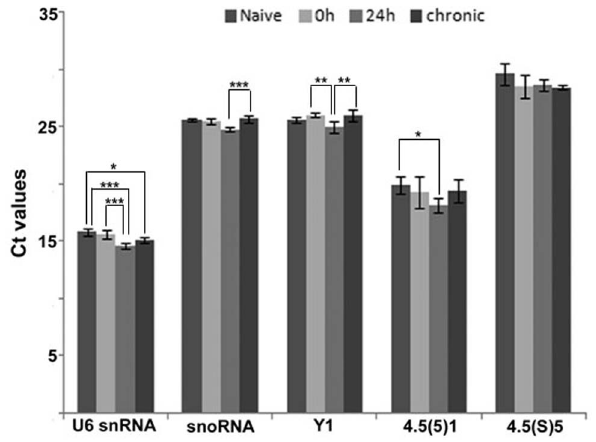
Figure 1. Levels of five non-coding RNAs candidate reference genes for microRNA qRT-PCR analysis in the hippocampus of the systemic PILO-injected and control rats. Values are given in the form of RT-qPCR threshold cycle numbers (Ct values), mean +